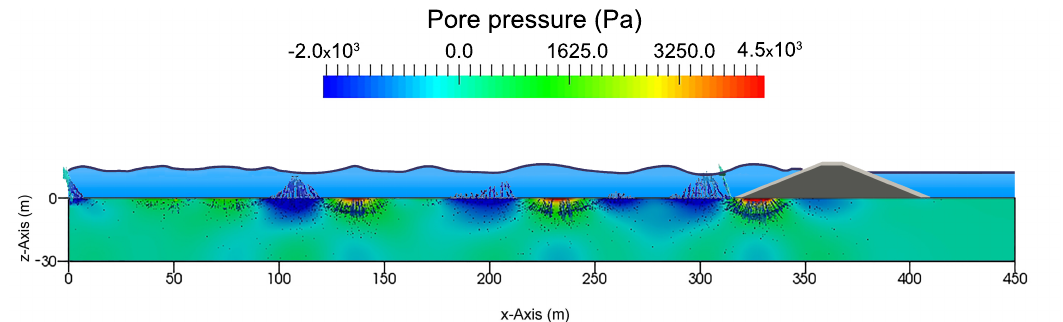
Figure 6. Wave-induced seabed response concerning a breakwater without submerged berm: transient pore pressure along with the seepage flow at t = 1281.6 s ( H mo = 4 m, T p = 8